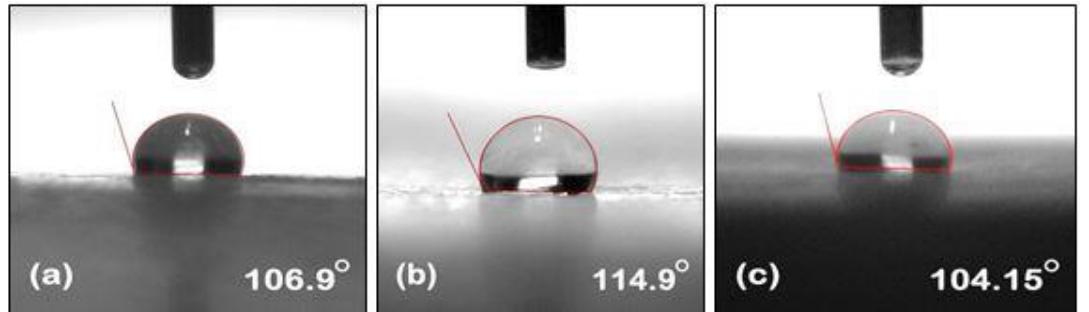
Figure 5. Measurement of contact angle of Unaged ( a ) neat epoxy ( b ) epoxy microcomposite ( c ) epoxy nanocomposite.